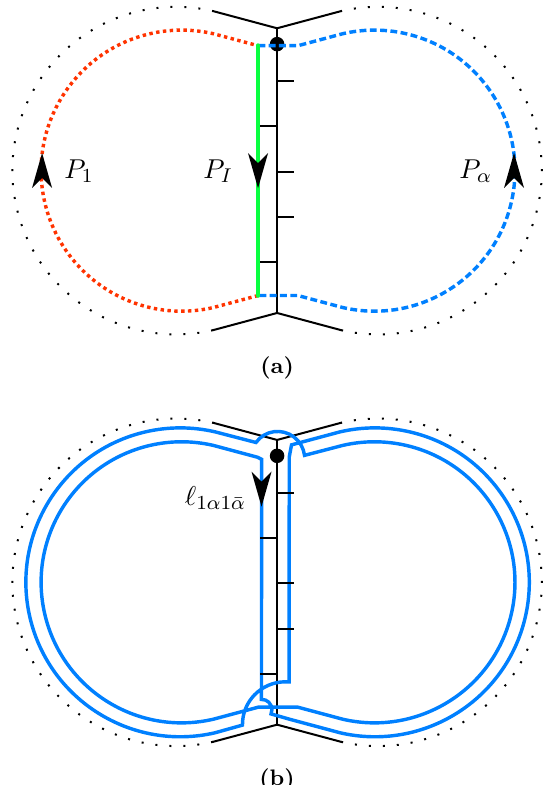
Figure 28. The path ‘ 1 (cid:11) 1(cid:22) (cid:11) always includes all of the edges in ‘ 1 at least twice. This (cid:12)gure illustrates why this is true in the case that ‘ 1 and ‘ (cid:11) have an edge in